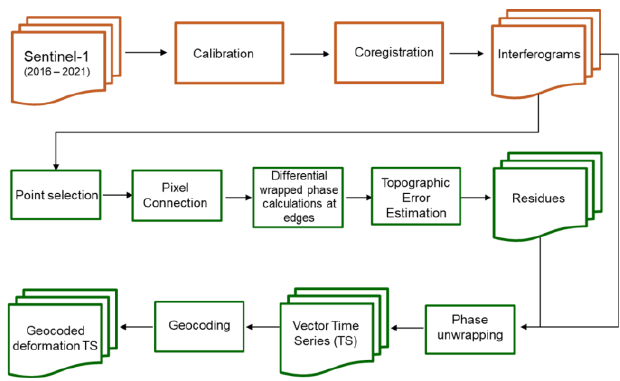
Figure 3 . Workflow of the procedure used in this